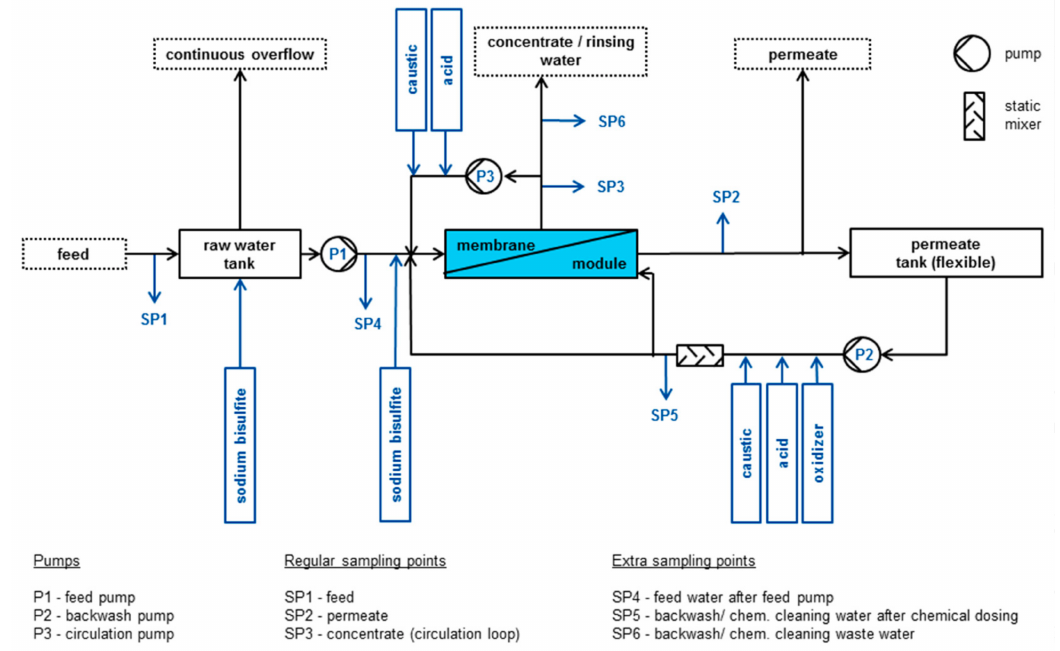
Figure 1. Settings and sampling points of the pilot